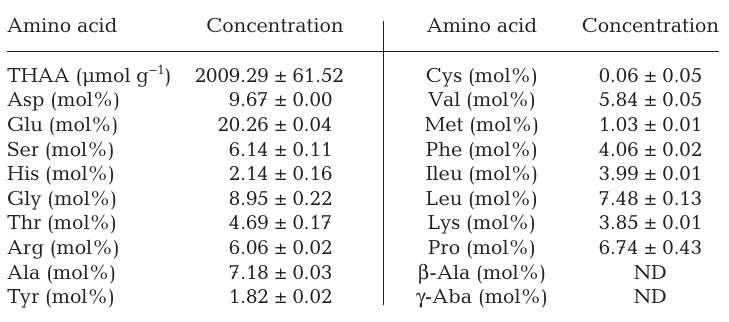
glutamic acid; Ser: serine; His: histidine; Gly: glycine; Thr: threonine; Arg: arginine; Ala: alanine; Tyr: tyrosine; Cys: cysteine; Val: valine; Met: methion- ine; Phe: phenylalanine; Ileu: isoleucine; Leu: leucine; Lys: lysine; Pro: pro- line; β -Ala: β -alanine; γ -Aba: γ -amino butyric acid; ND: not Amino acid Concentration Amino acid Concentration THAA (µmol g −1 ) 2009.29 ± 61.52